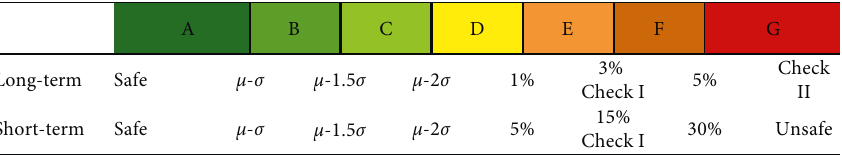
Figure 8: Customized traffic light model inspired by energy consumption